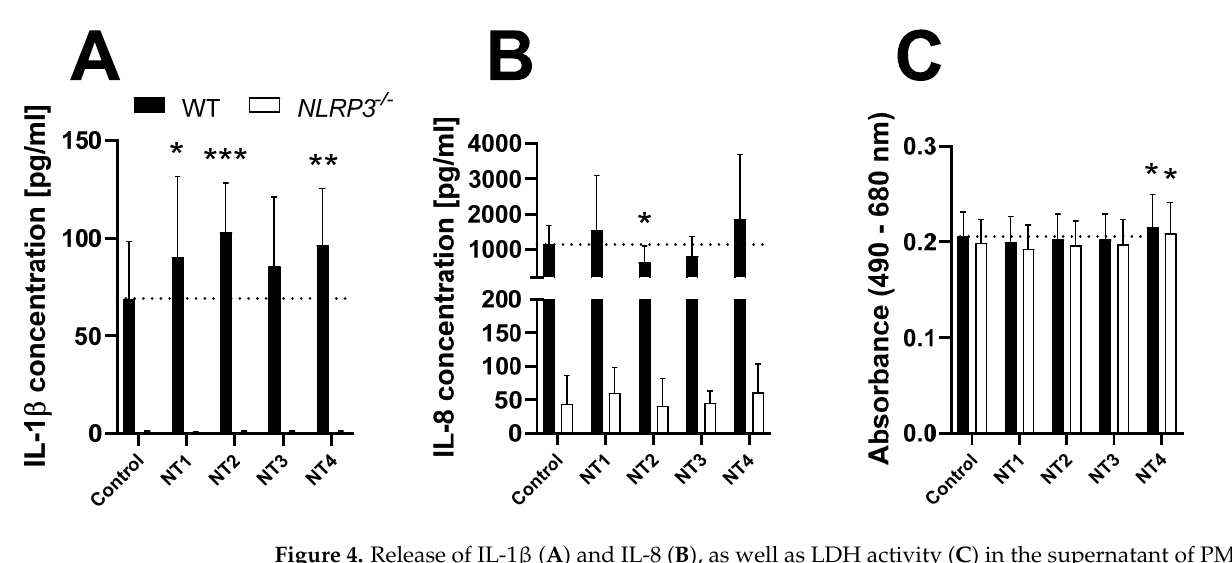
Figure 4. Release of IL-1 β ( A ) and IL-8 ( B ), as well as LDH activity ( C ) in the supernatant of PMA- differentiated THP-1 WT (full bars) or NLRP3 − / − (open bars) cells after 24 h treatment with 50 µ g/cm 2 of four different TiO 2 samples. Cytokine data is depicted as relative values compared to the WT control, LDH data is depicted as relative values compared to the respective control. Mean ± SD of N = 4, * p < 0.05, ** p < 0.01, and *** p < 0.001 compared to the respective control.